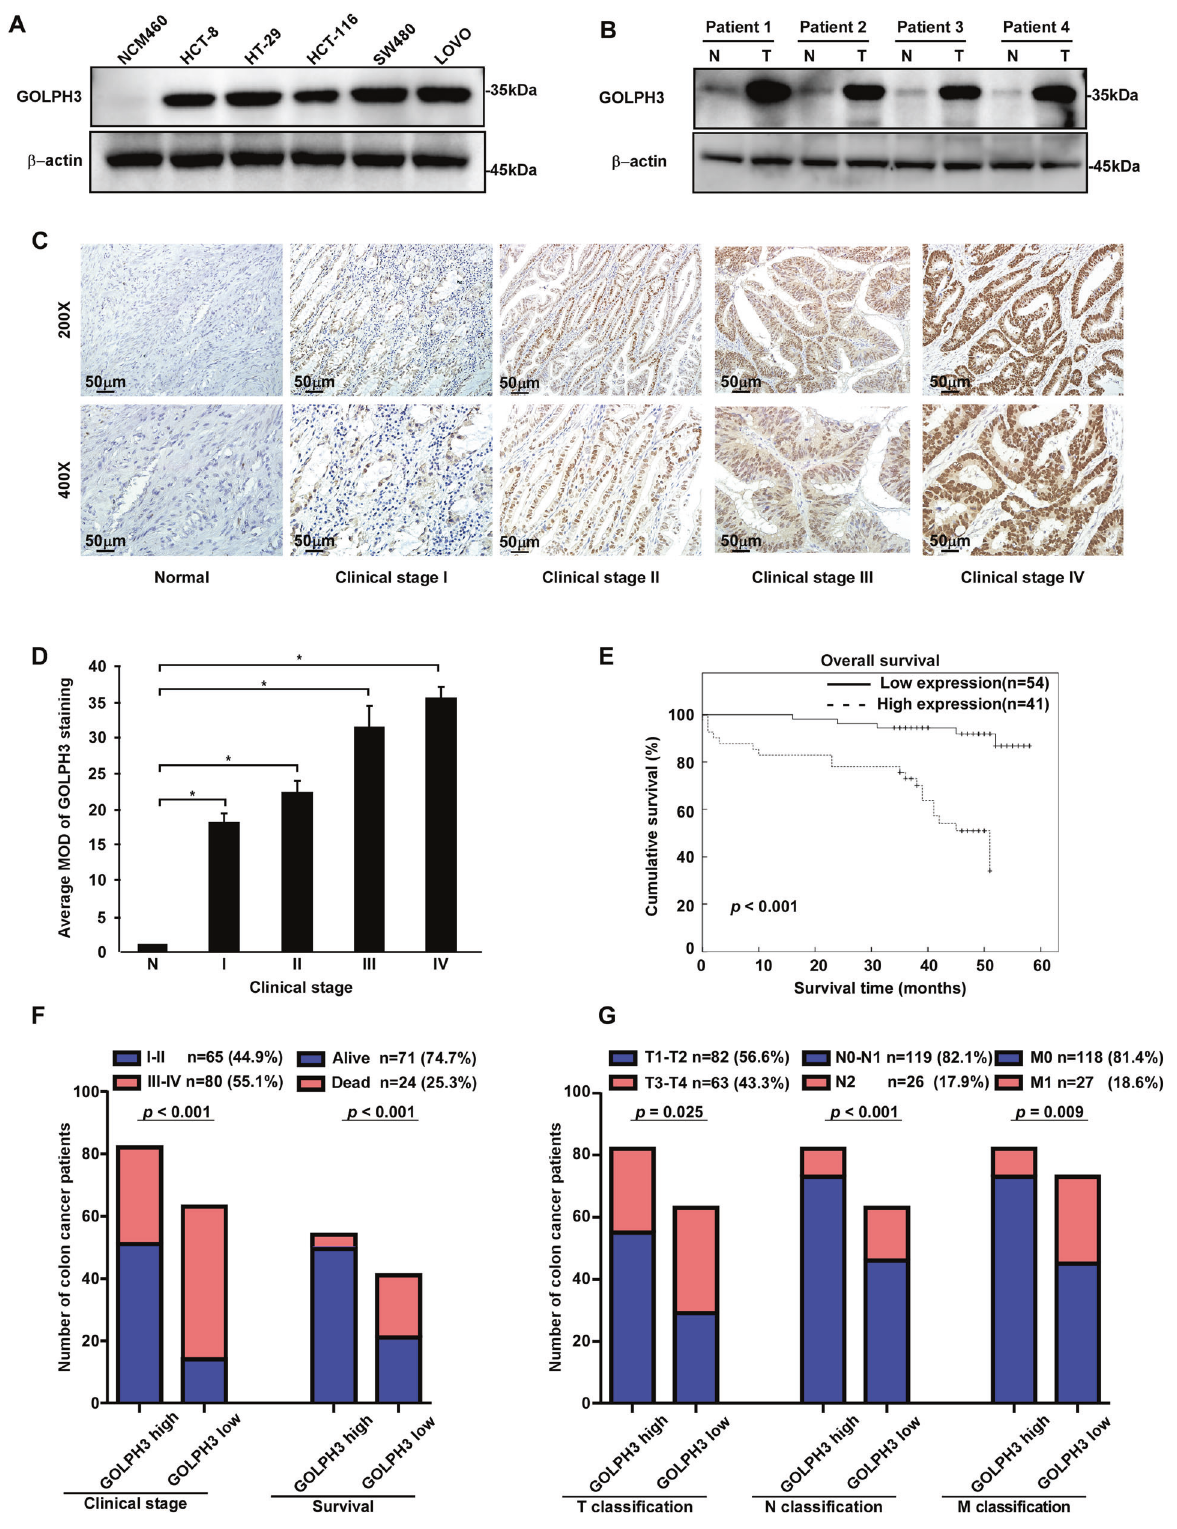
formed. Autophagy fl ux was visualized using RFP-GFP-targeted LC3 fl uorescence. We observed that GOLPH3 overexpression increased the level of autolysosomes (red dots), while